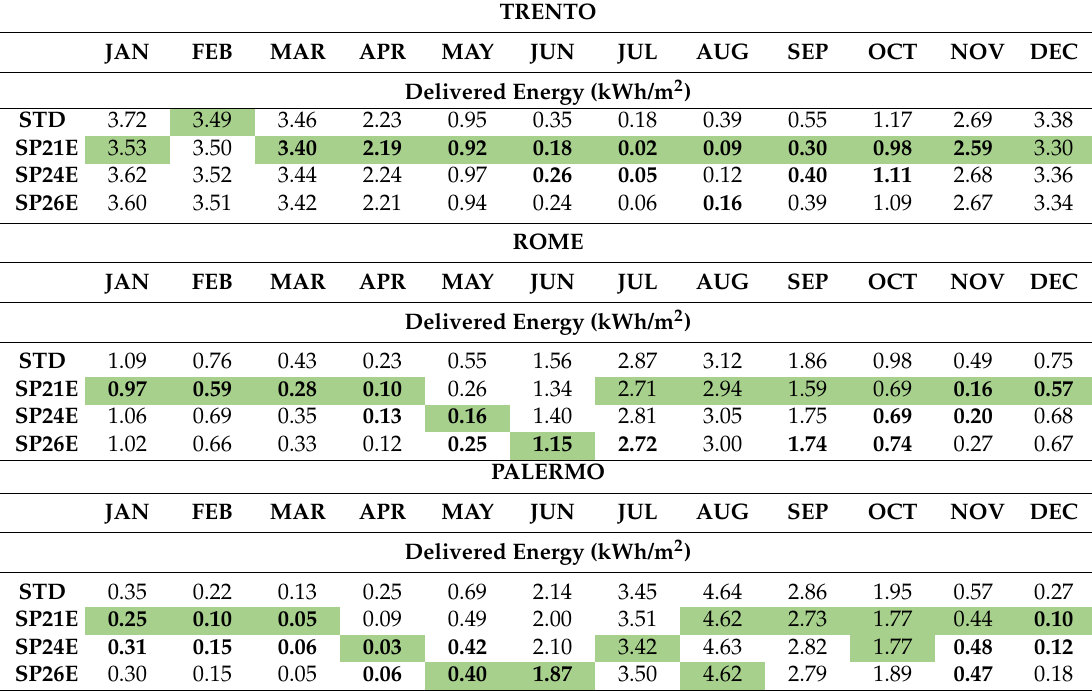
Table 9. Delivered energy on a monthly basis for STD and the building provided with the three PCM for the city of Trento, Rome and Bolzano. Green cells highlight the best performing material for each month. Numbers in bold underline the months where the PCM is in phase